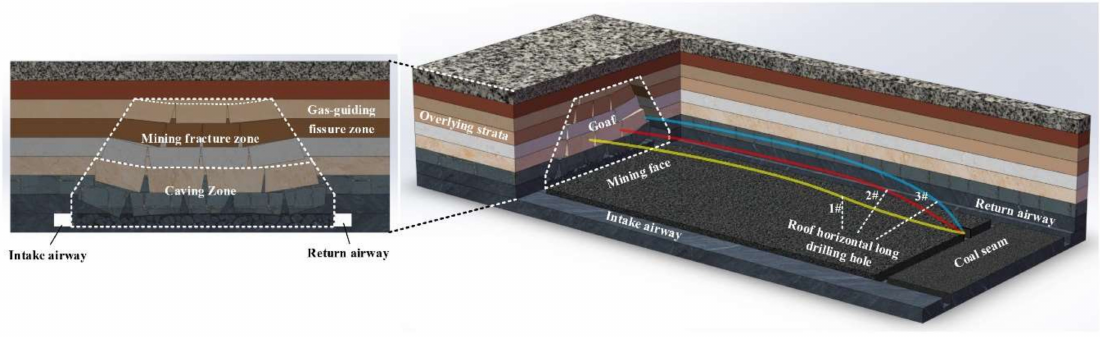
Figure 2. Schematic of a long horizontal borehole and related branch holes drilled for CBM drainage in worked seam.